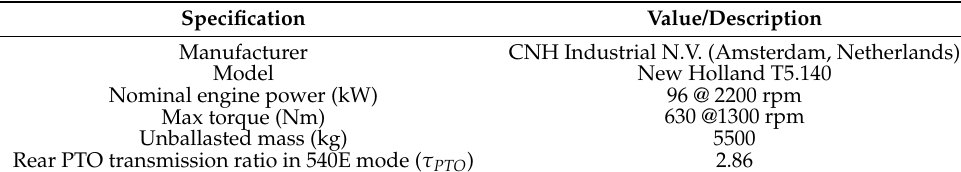
Table 2. Main specifications of the tractor used for the tests claimed by the manufacturer.